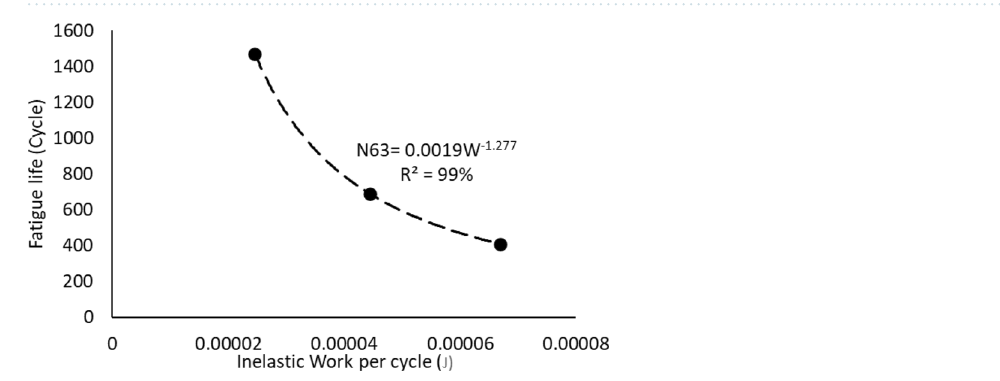
Figure 12. The relationship between the fatigue life and the average inelastic work per cycle for SAC305 solder joints that were examined at room temperature.